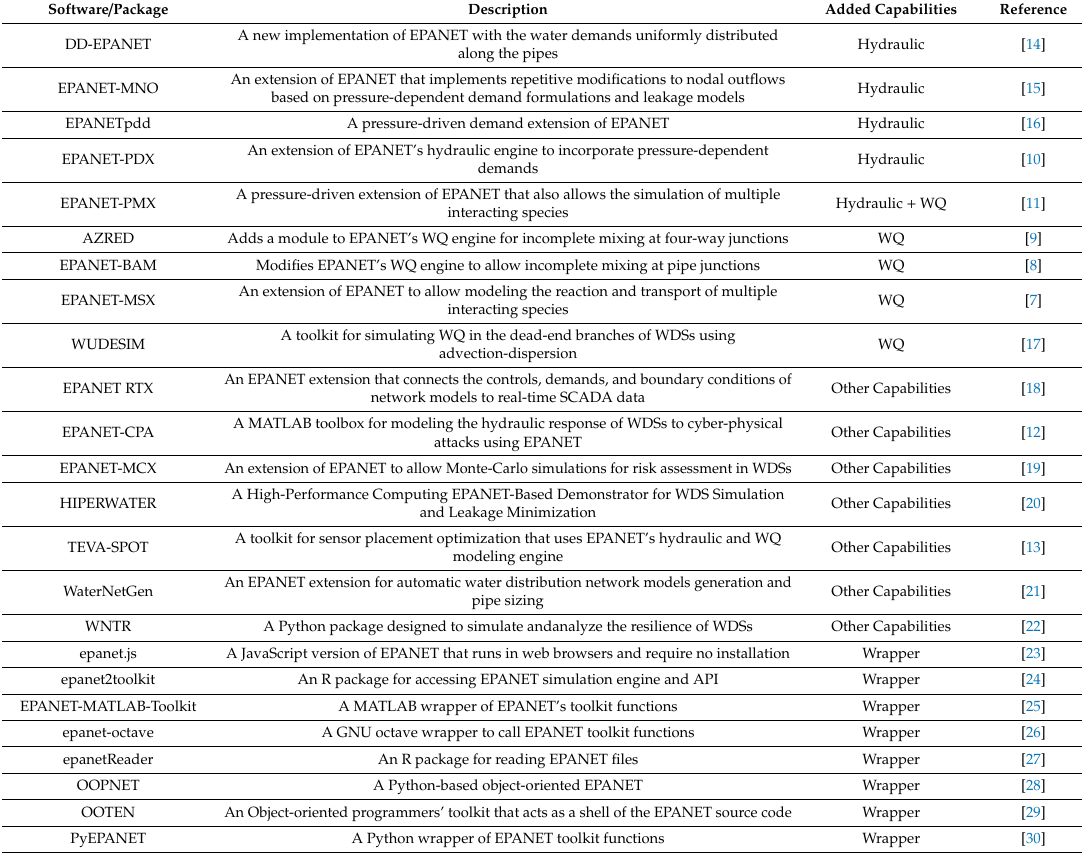
Table 1. Examples of EPANET extensions and wrapper